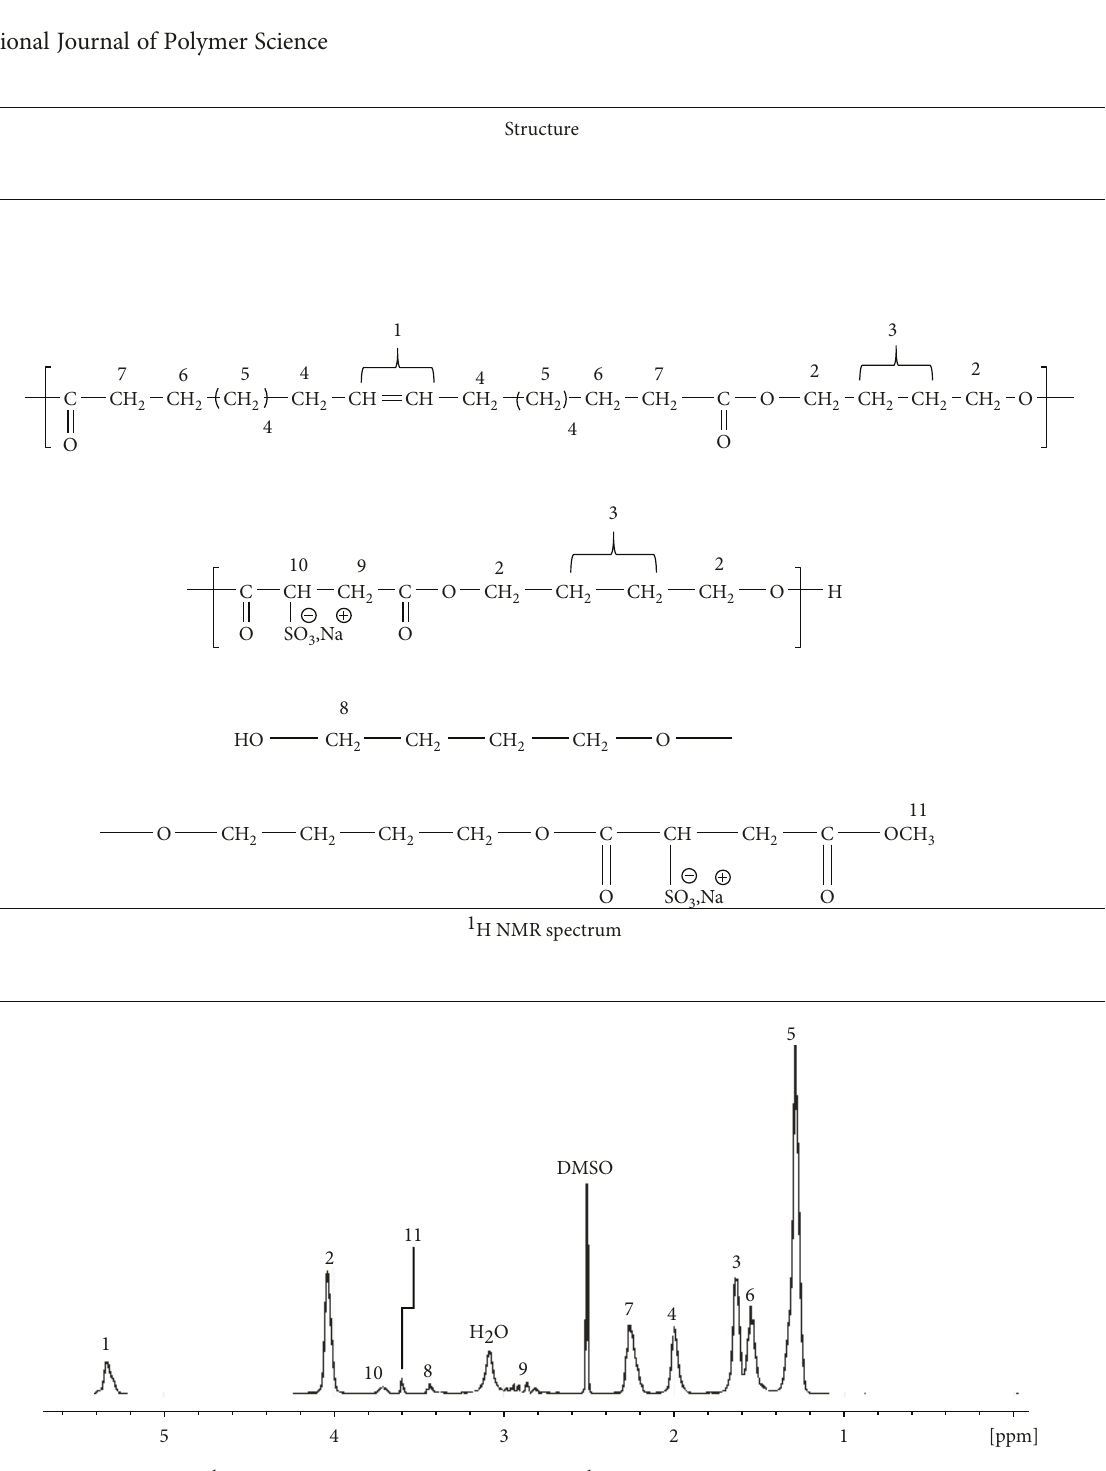
Ss 301 H NMR spectrum (400MHz, 70